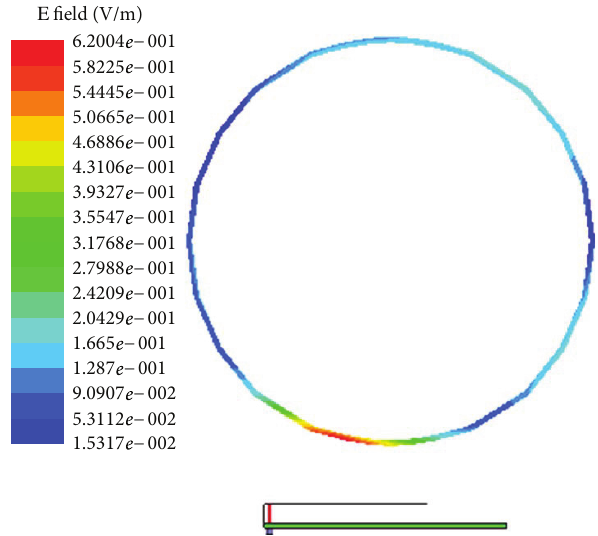
F 18: �-�eld strength in CSF tissue at